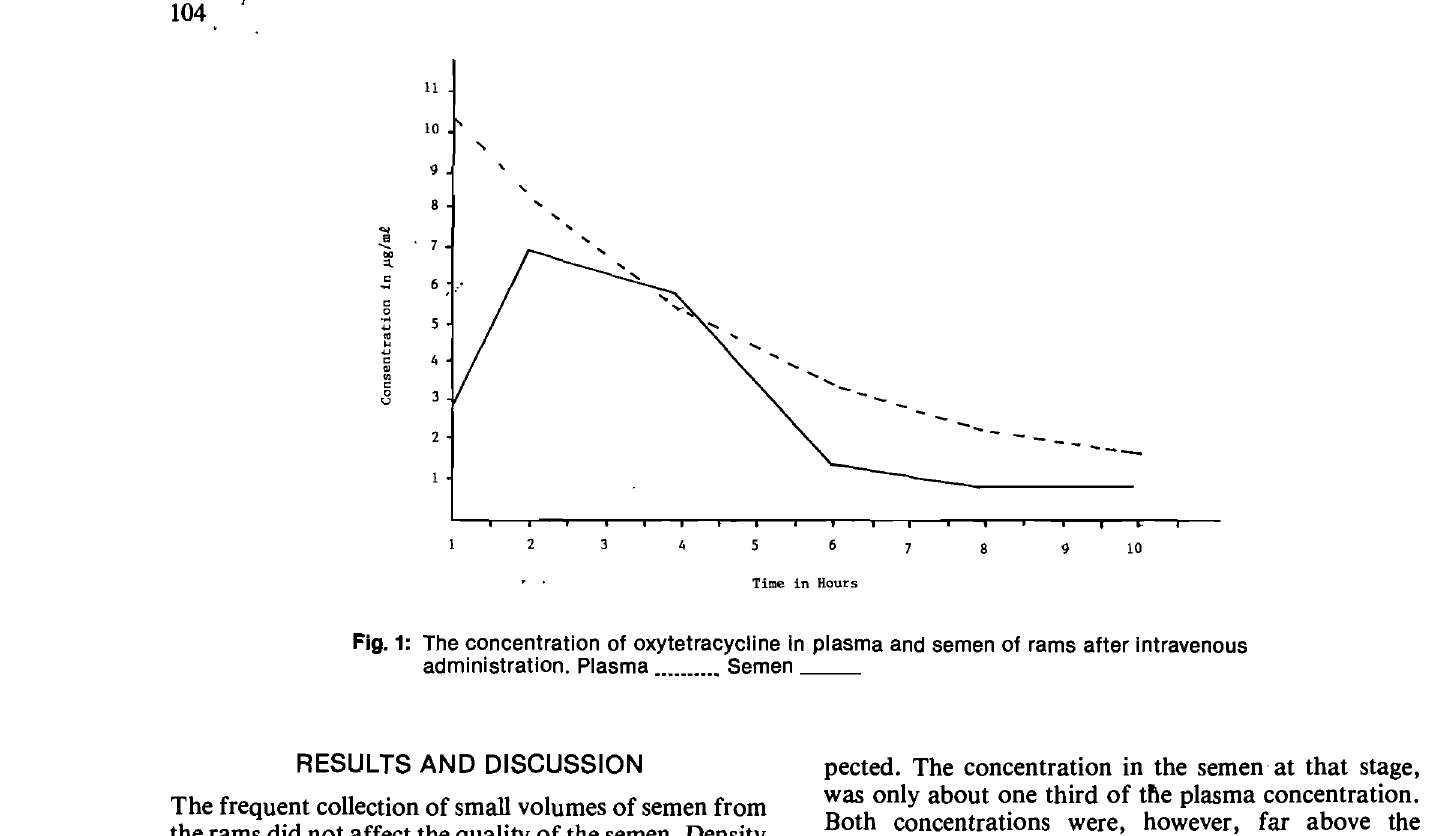
Fig. 1: The ?~ncen~ration of oxytetracycline In plasma and semen of rams after intravenous administration. Plasma •.•...•••• Semen __